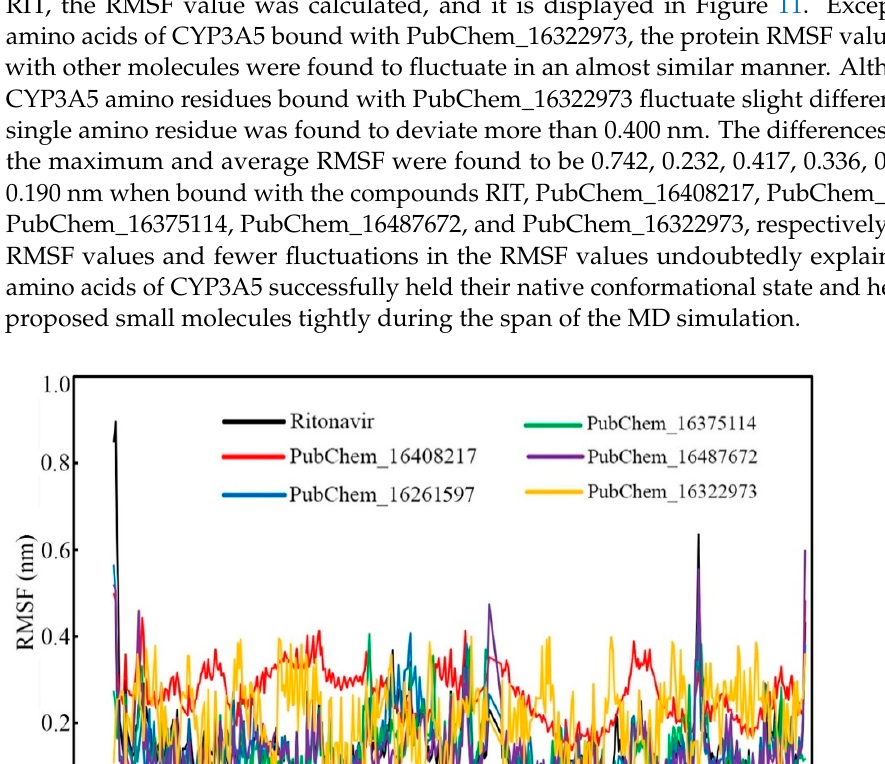
Figure 12. RoG of CYP3A5 bound with CYP3A5 molecules.